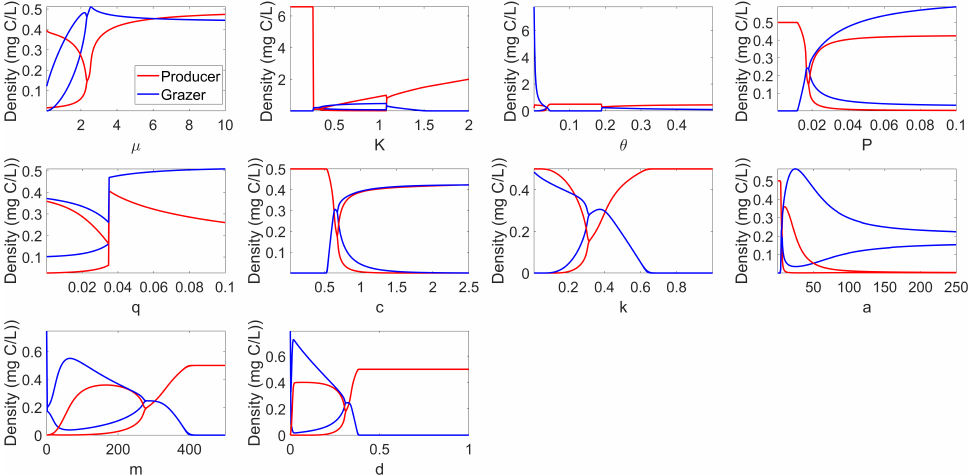
Figure A1. Bifurcations for system Equations (18) and (19) with respect to each of the model